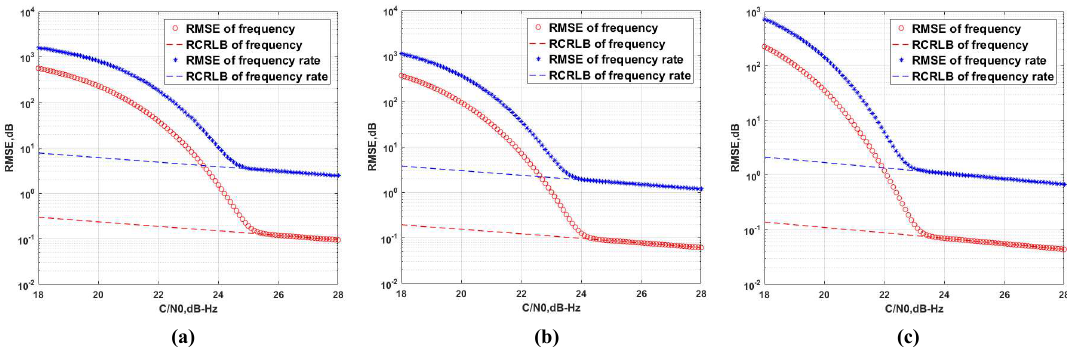
Figure 18. Theoretical MSE performance predictions for different integration times: ( a ) 0.15 s; ( b )0.2 s; ( c ) 0.25 s.